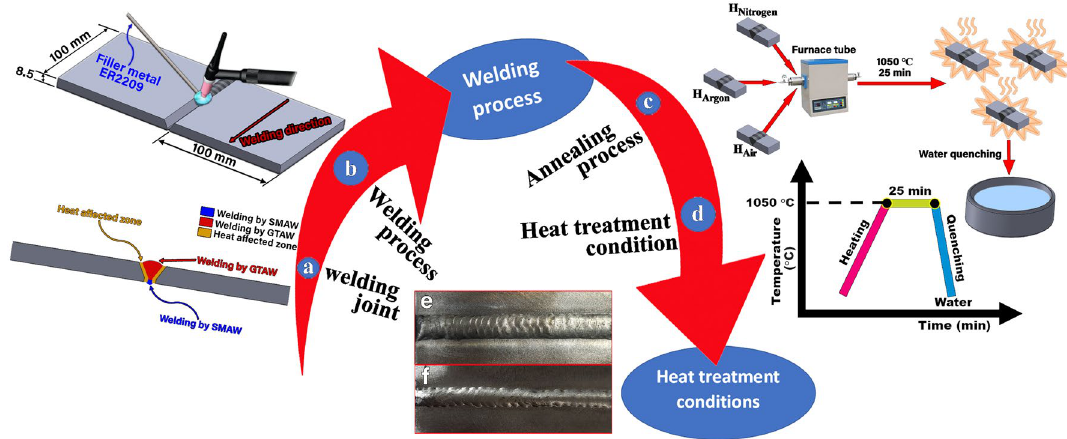
Figure 3. (a) Schematic welding joint, (b) schematic welding process, (c) schematic annealing process, (d) heat treatment condition, (e) cap of welding, and (f) root of welding.